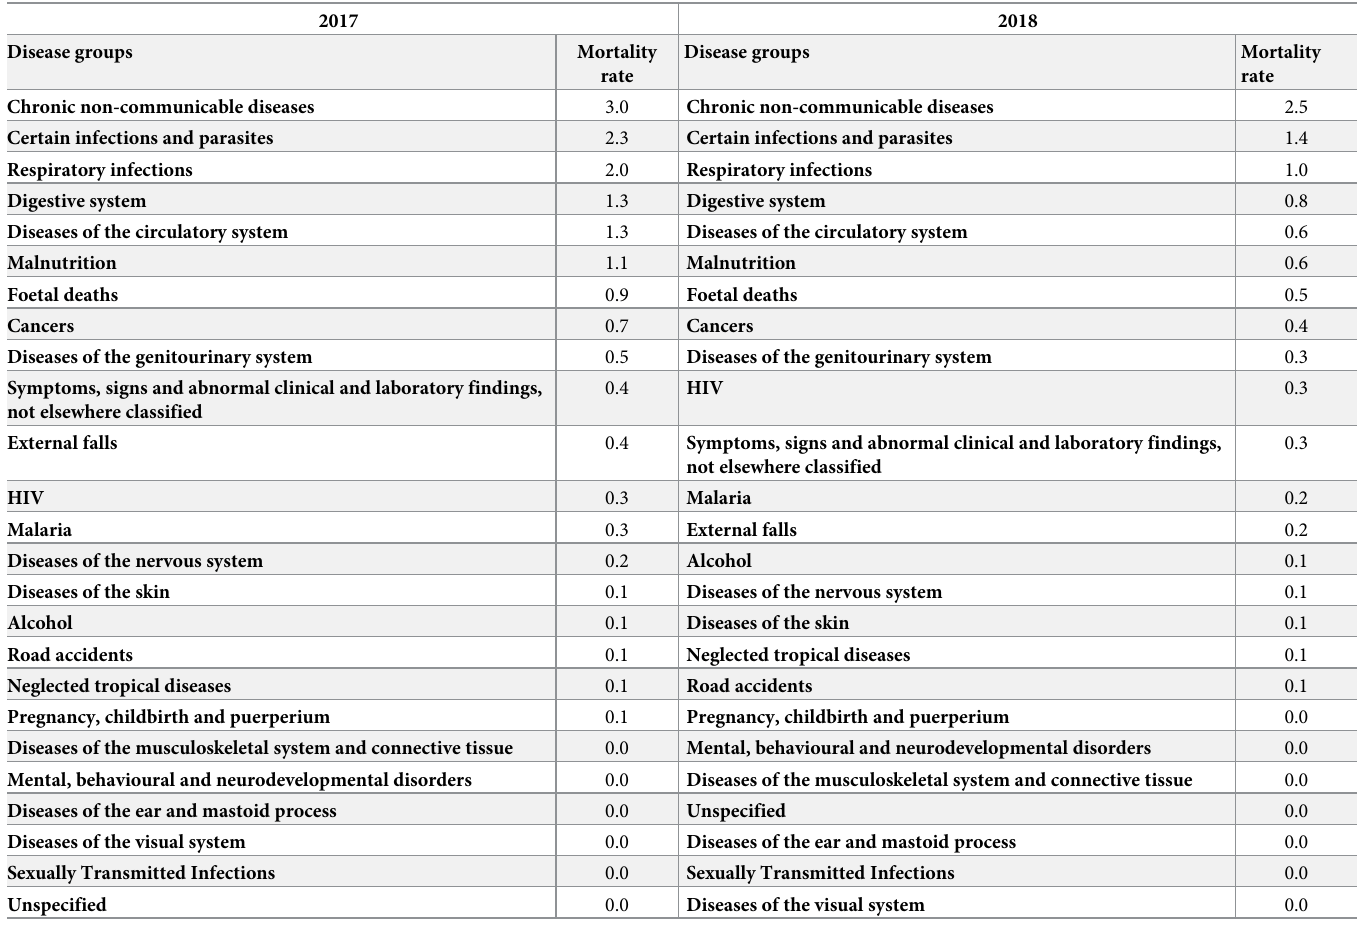
Table 3. Ranked mortality rate by cause of death at health facilities Ghana, 2017 and